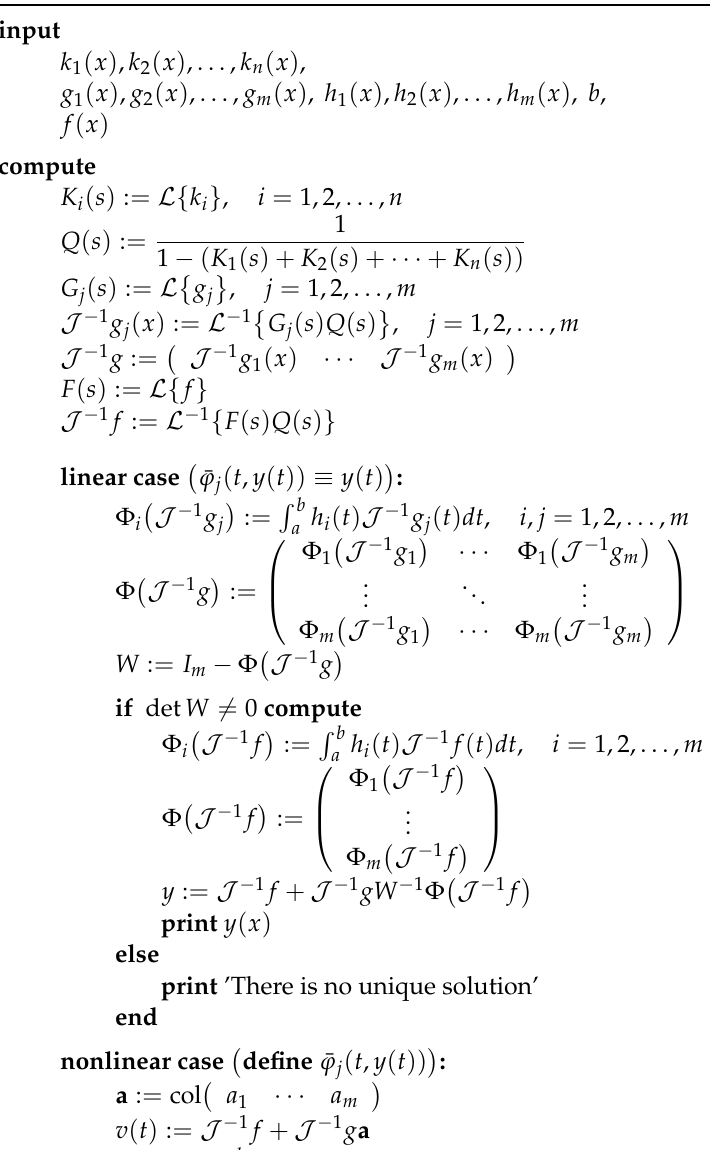
Algorithm 1: Algorithm for the implementation of the Laplace transform